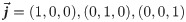
Comparison between j→=(1,0,0),(0,1,0),(0,0,1).